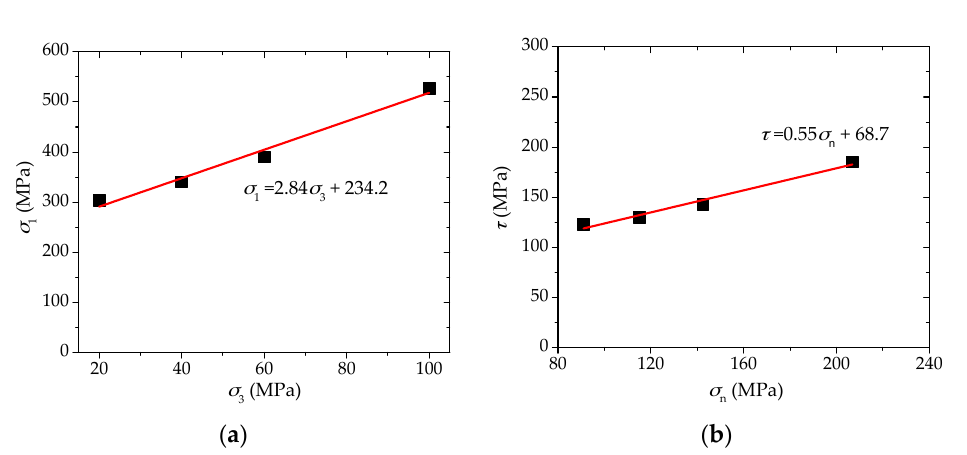
Figure 12. ( a ) Peak strengths of Shale-5 sample ( β = 60 ◦ ) under various confinements ( σ 3 = 20, 40, 60, and 100 MPa); and ( b ) normal and shear stresses on the weak planes based on the data in ( a ) and the linearly fitted equation.